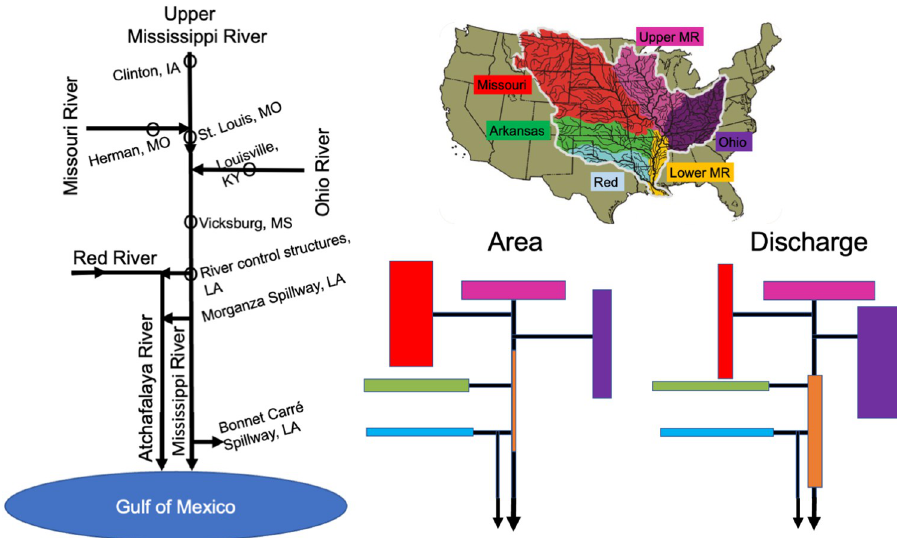
Fig 1. A schematic model of the Mississippi River watershed and major subbasins, comparative areas and discharge volumes and major water distributions with the five locations of the discharge measurements. The relative area and discharges are proportional amounts (expressed as a percent of the total) for 1973–1994. The baseline map of six subbasins is from the Mississippi Valley Division of the U.S. Army Corps of Engineers